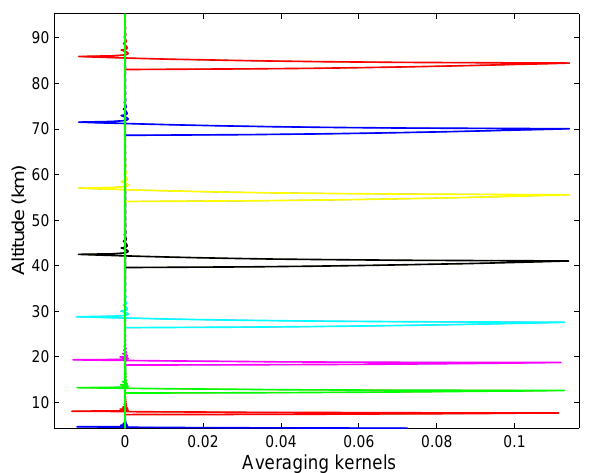
Fig. 1. Sampling resolution in vertical (R03059/S018, azimuth = 0 ◦ ), typical (R03059/S052, azimuth = 30 ◦ ) and oblique (R03059/S001, azimuth = 54 ◦ ) occultations.